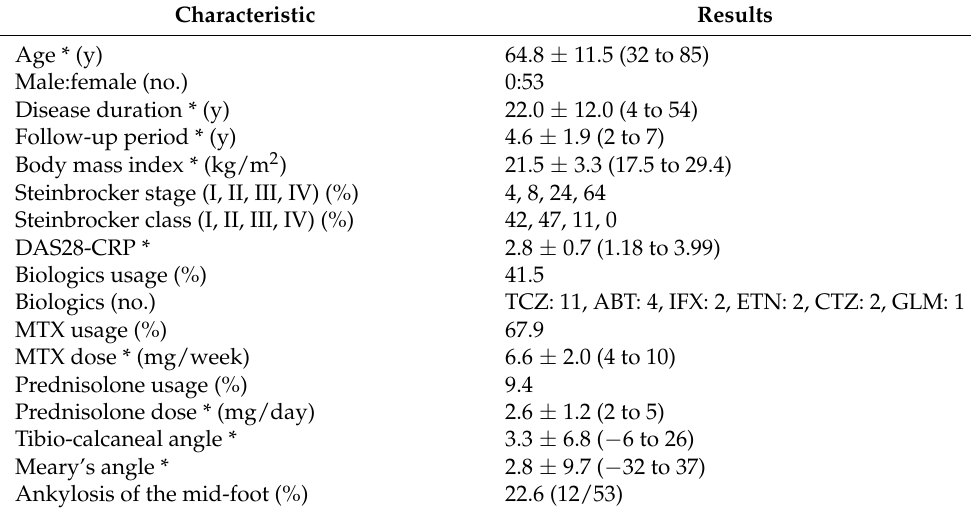
Table 1. Characteristics of patients with rheumatoid arthritis (RA) and hallux valgus deformity ( N = 53).